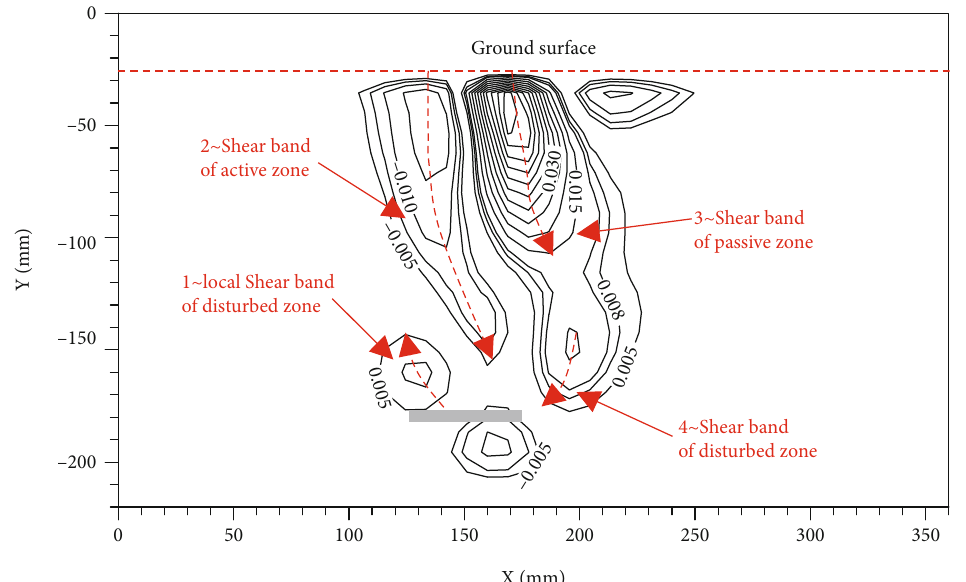
Figure 6: Shear strain fi eld at the ultimate load for D